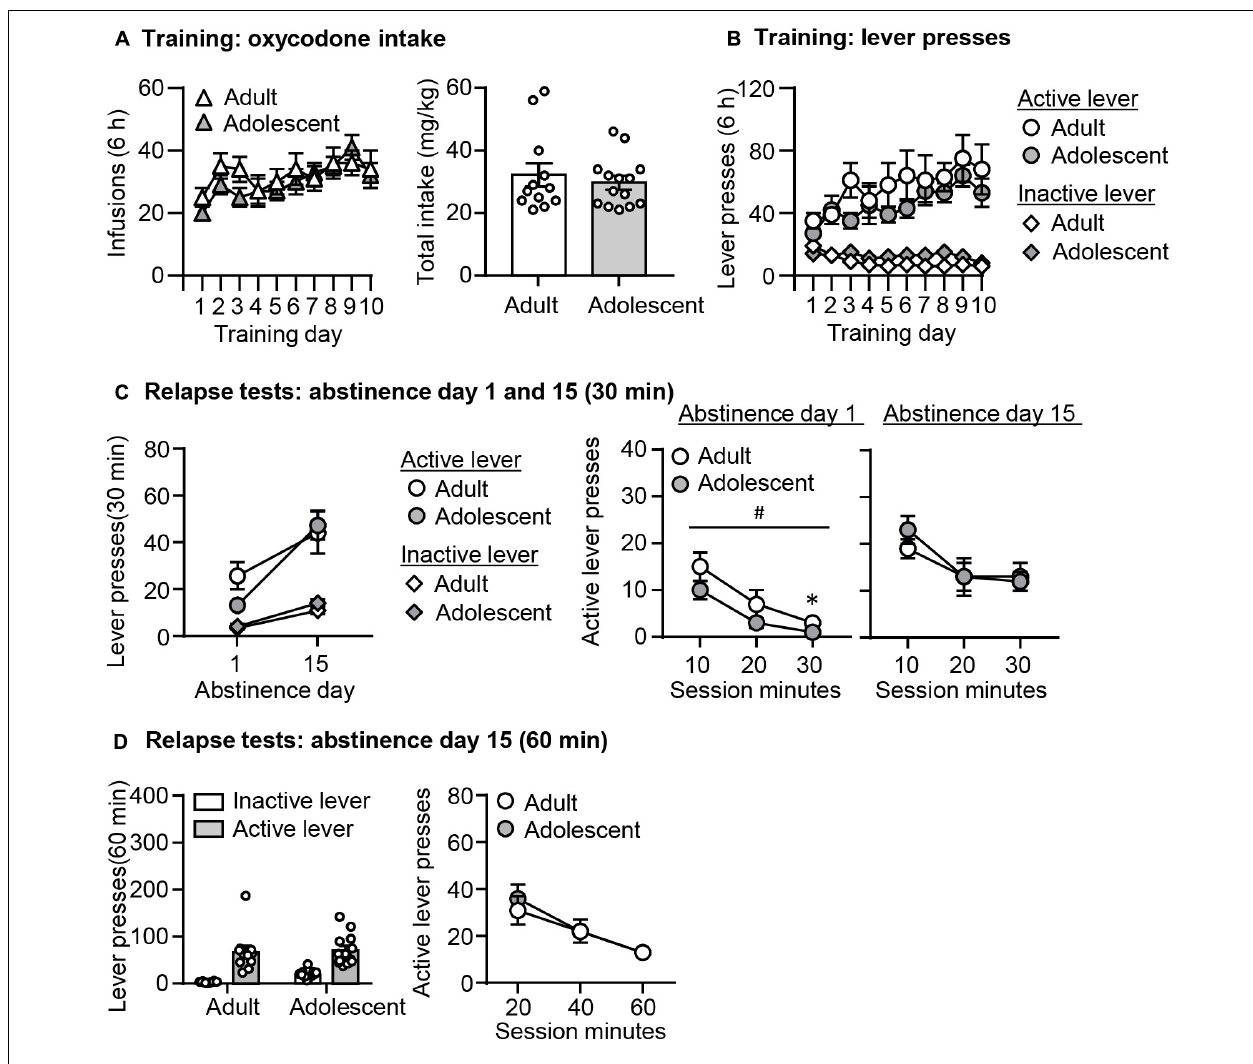
FIGURE 3 | Incubation of oxycodone craving following adult-onset and adolescent-onset oxycodone self-administration under the group-housing condition. (A,B) Data are mean ± SEM number of oxycodone (0.1 mg/kg/infusion) infusions, total oxycodone intake, and lever presses during the ten 6-h daily self-administration sessions for Exp. 2. During training, active lever presses were reinforced on an FR1 20-s timeout reinforcement schedule, and oxycodone infusions were paired with a 5-s tone-light cue. (C) Relapse test on abstinence days 1 and 15: Data are mean ± SEM of active and inactive lever presses during the 30-min relapse test on abstinence day 1 and the first 30 min of the 60-min relapse test on abstinence day 15. # Main effect of Age; *Different from Adult, p < 0.05. (D) Relapse test on abstinence day 15: Data are mean ± SEM of active and inactive lever presses during the 60-min relapse test. During testing, active lever presses led to contingent presentations of the tone-light cue previously paired with oxycodone infusions during training, but not oxycodone. n =